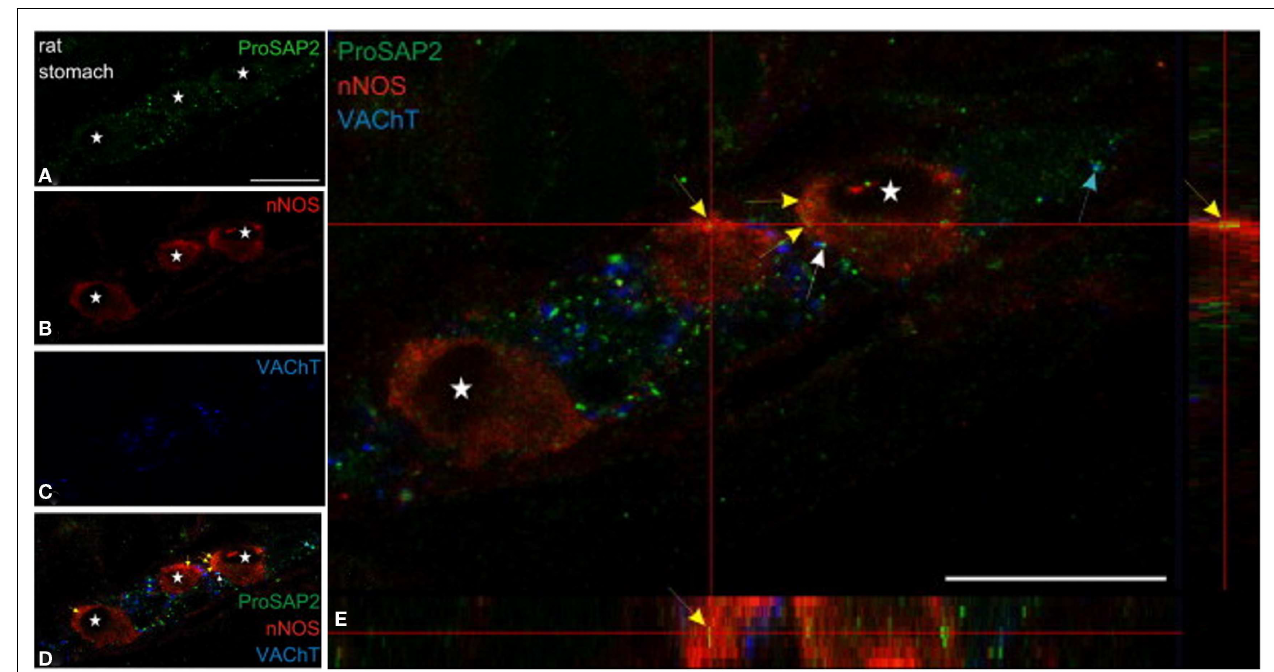
whether the distribution is only restricted to the surface.The higher power image shows diffuse distribution of nNOS in the both the cell cytosol and membranous region, colocalized with the submembranous location of shank3. Note that shank3 localization in nitrergic nerve terminals has not been examined. Modified with permission from Raab et al.